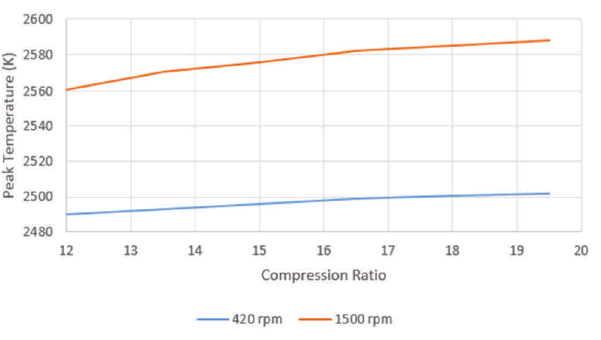
Fig. 6c. Graph of peak temperature against compression